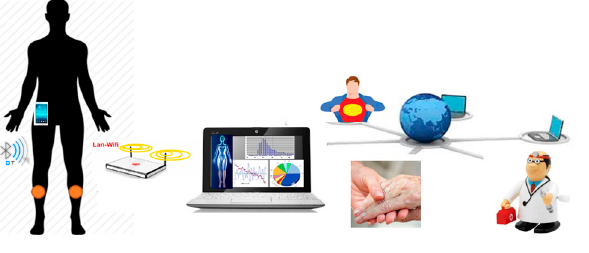
Figure 1. Sketch of the